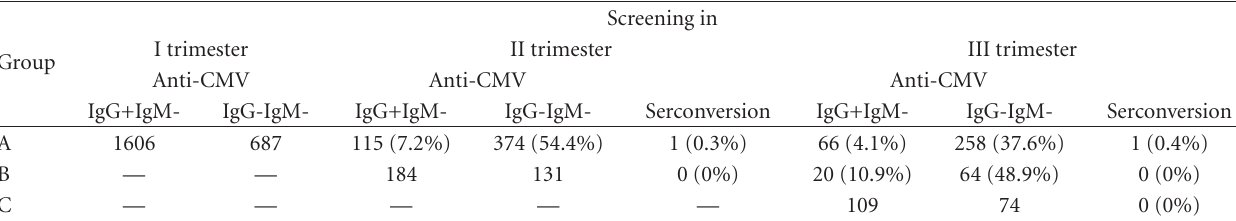
Table 2: Number of subsequent screenings and anti-CMV antibody seroconversions in women who were seronegative or seropositive at first screening.